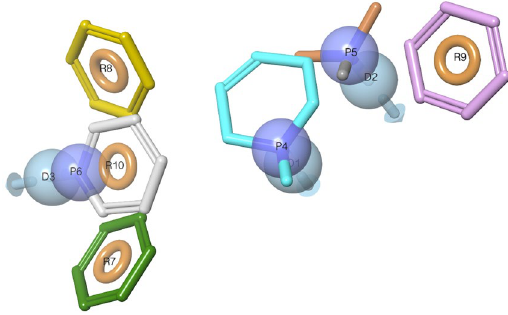
Figure 1. Histamine H 3 receptor pharmacophore model used in the virtual screening for new ligands. The pharmacophore was based on a receptor residue – ligand moiety fragment library derived from GPCR crystal structures (Supplementary Table 1), and built with Phase 61 . The pharmacophore elements include three hydrogen bond donor (D1-3, light blue), three cation (P4-6, blue), three aromatic (R7, R9 and R10; orange) and one dual aromatic/hydrophobic (R8, orange)